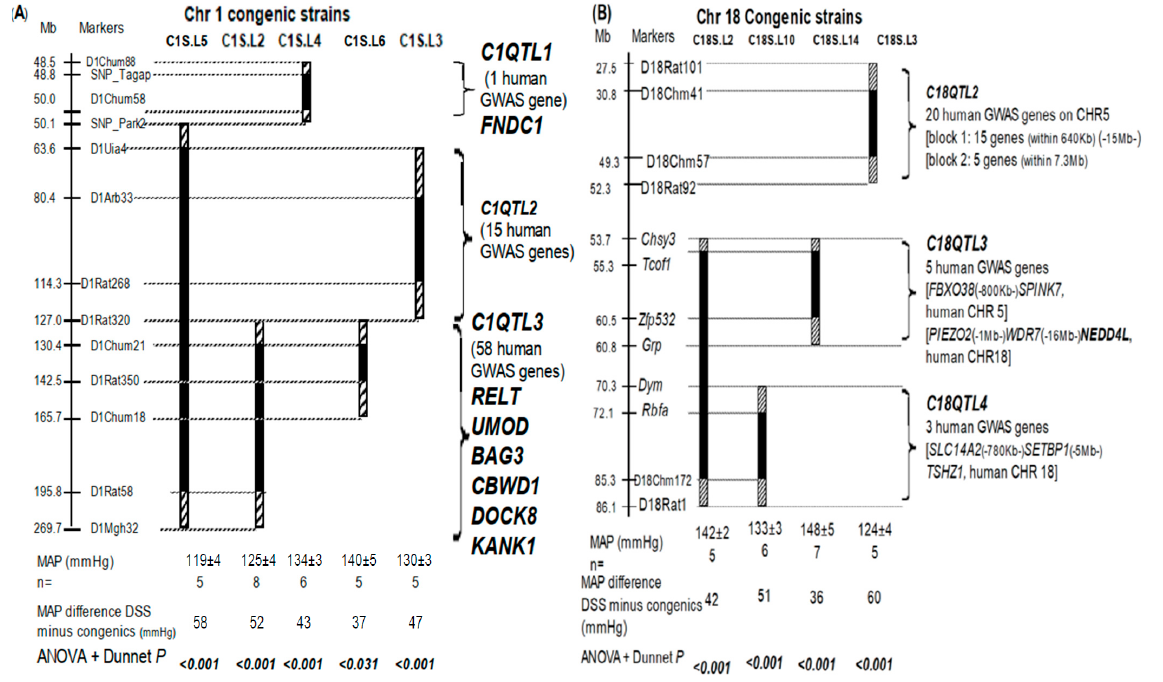
Figure 1. Congenic knock-in genetics defining chromosome intervals harboring BP QTLs in vivo in causation. Solid bars under congenic strains symbolize the hypertensive Dahl salt-sensitive (DSS) chromosome fragments that have been replaced by those of normotensive Lewis. Striped bars on the ends of solid bars indicate ambiguities of crossover breakpoints between markers. The full gene nomenclature corresponding to their abbreviations is given in the Table 1 legend. Mean arterial pressures (MAPs) for DSS and congenic strains are averaged for the period of measurement and are given at the bottom of the map. Significant p values are emphasized in bold and italics. ± indicates SEM. ( A ) Chr 1; ( B ) Chr 18. Table 1. DSS QTLs with missense mutations functionally capturing human GWAS orthologs.